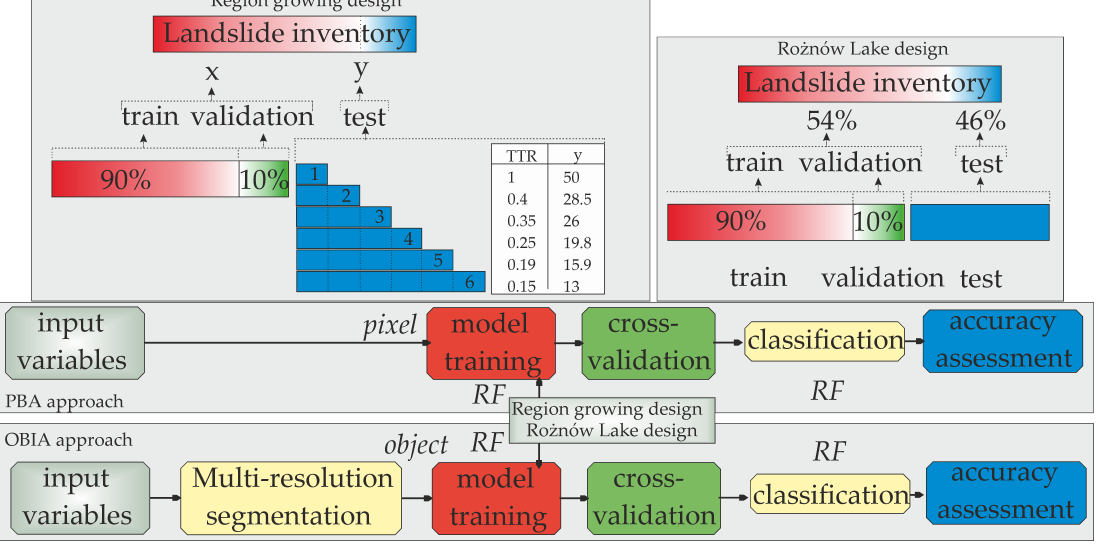
Figure 4. Steps performed in the pixel-based approach (PBA) and object-based image analysis (OBIA)